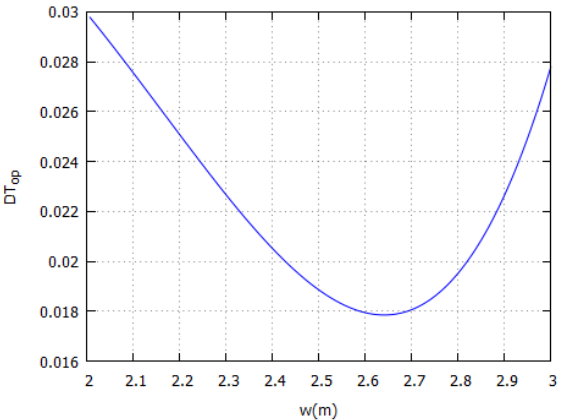
Figure 12. First derivative of the analytical operative temperature for a 21-type radiator, h = 0.9